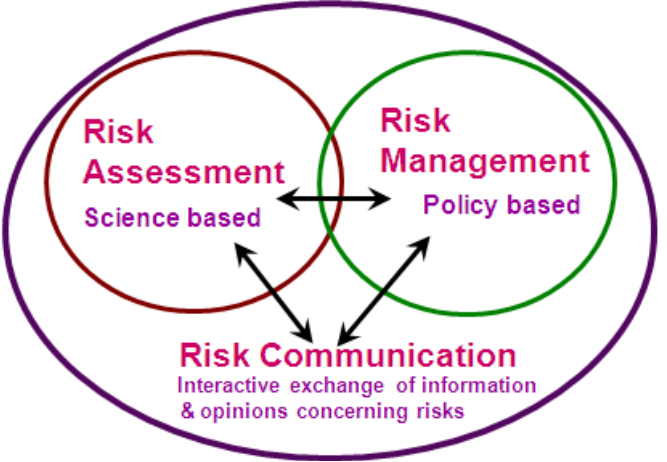
Figure 1. Risk analysis framework (redrawn from